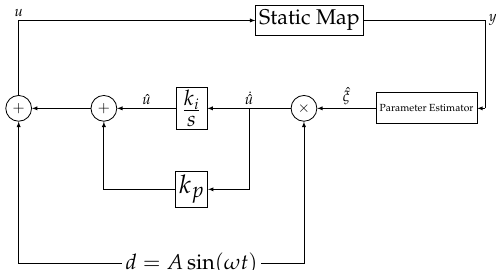
Figure 5. Proportional-integral extremum seeking control scheme